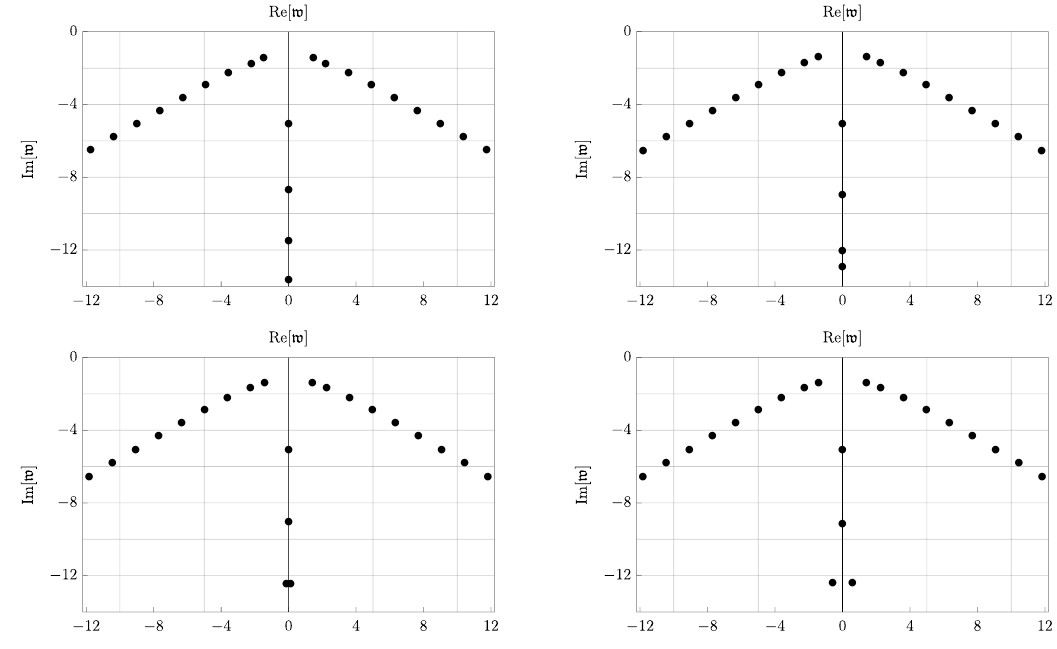
Figure 4 . The scalar channel spectrum at q = 0 : 5, plotted for (cid:11) = 0 : 02 and (cid:13) 2 = f 0 : 005, 0 : 0065, 0 : 0067, 0 : 007 g , in progression from top-left, top-right to bottom-left and bottom-right.